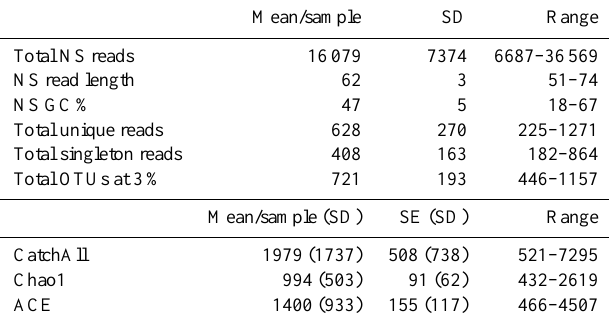
Table 1. Sequencing statistics and OTU richness estimates for 16 bacterial communities along the eastern Atlantic Ocean. The statis- tical estimates of the total OTU richness of each sampled commu- nity were determined from the observed OTUs using the CatchAll parametric estimator and the non-parametric estimators Chao1 and ACE; all implemented in CatchAll V3.0. NS=Non-singletons, the remaining reads after the removal of reads present only once (sin- gletons). SD=standard deviation. SE=standard error.